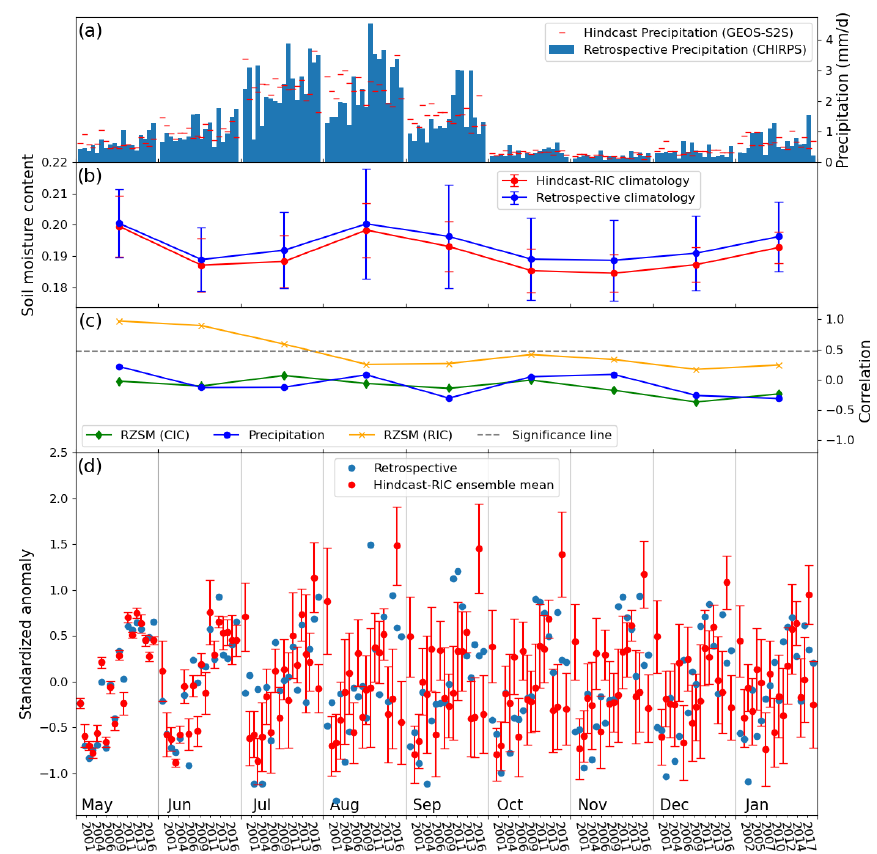
Figure 5. Same as Fig. 4, but for the Indus